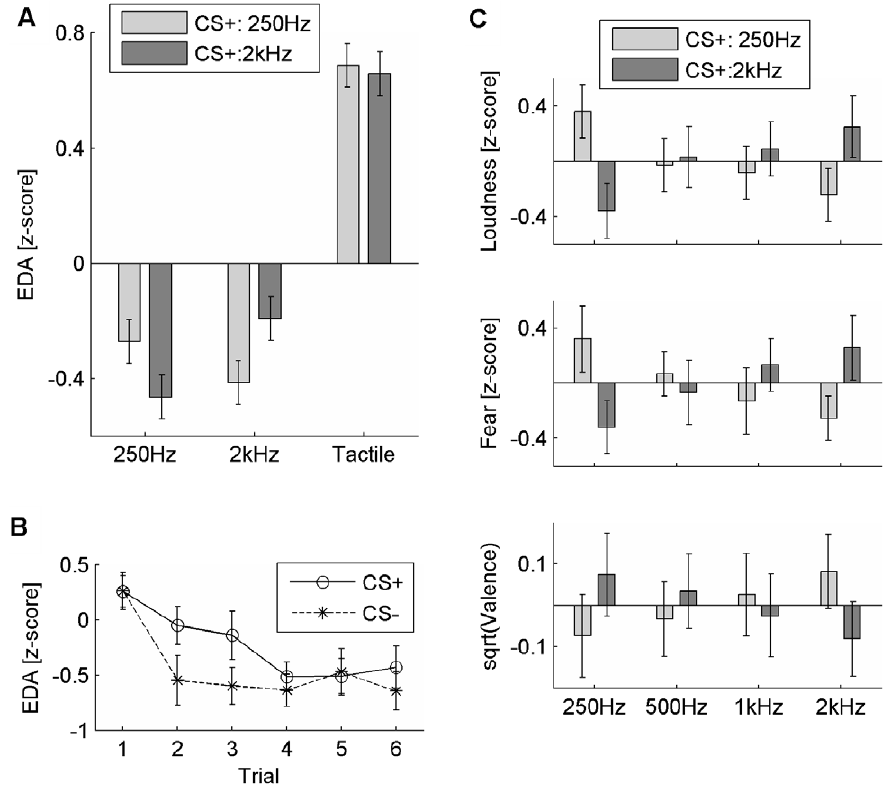
Figure 2. Results. ( A ) Mean EDA induced by auditory and tactile stimuli during conditioning phase shown for the two conditioning groups (CS + : 250 Hz vs. CS + : 2 kHz). SE is indicated. ( B ) Average EDA induced by CS + and CS- in the conditioning phase (the two conditioning groups combined) at different trials. Standard errors of the means are indicated. ( C ) Interaction effect of conditioning group and sound on loudness (top), fear (middle) and valence (bottom) judgments. Main effects and grand means are removed. SE is indicated.